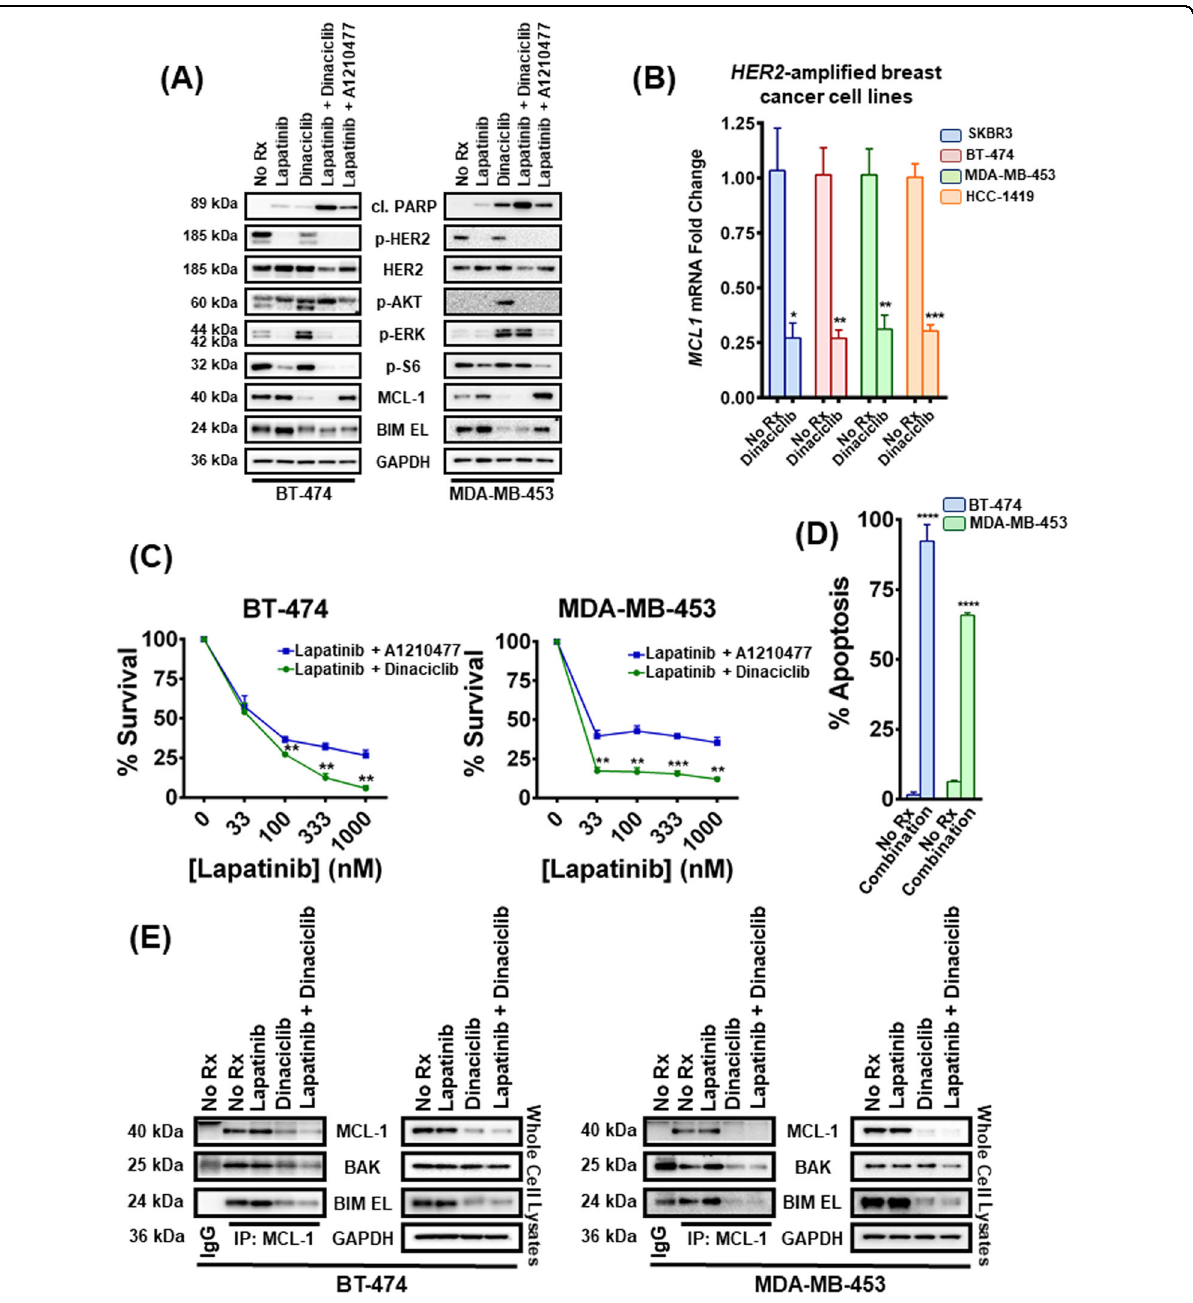
Fig. 1 Dinaciclib sensitizes HER2- ampli fi ed breast cancer cells to lapatinib and liberates BAK from MCL-1. A BT-474 and MDA-MB-453 cells were treated with no drug, 1 μ M lapatinib, 100nM dinaciclib, their combination and the combination of 1 μ M lapatinib with 10 μ M A1210477 for 6 and 12h, respectively. Whole-cell lysates were prepared, subjected to western blotting and probed for the indicated proteins. B Cells from SKBR3, BT-474, MDA-MB- 453, and HCC-1419 HER2 -ampli fi ed breast cancer cell lines were treated with no drug or 100nM dinaciclib for 2h, and levels of the abundance of MCL-1 mRNA were analyzed by qPCR. Data are normalized to ACTB ; n = 3; error bars indicate ±SEM. C BT-474 and MDA-MB-453 cells were treated with increasing concentrations of lapatinib and 10 μ M A1210477 or with increasing concentrations of lapatinib and 100nM dinaciclib for 24 and 72h respectively, and the percentage of viable cells was determined. n = 3; error bars indicate ±SD. D BT-474 and MDA-MB-453 cells were treated with no drug or the combination of 1 μ M lapatinib and 100nM dinaciclib for 24 and 72h, respectively and the percentage of annexin V/PI-positive cells was determined by FACS. n = 3, error bars indicate ±SD ( “ No Rx ” : No drug). E MCL-1 complexes were immunoprecipitated from the indicated HER2 -ampli fi ed breast cancer cell lines following 6h (BT-474) and 12h treatment (MDA-MB-453) with no drug, 1 μ M lapatinib, 100nM dinaciclib, and their combination. An IgG-matched isotype antibody was served as an immunoprecipitation control. The interaction between MCL-1 and BIM EL/BAK proteins was investigated ( “ No Rx ” : No drug). For Fig. 1B – D two-tailed Student ’ s t test was performed. p values were corrected for multiple testing using the Bonferroni method. Differences were considered statistically different if p <0.05. A p value<0.05 is indicated by *, p <0.01 by **, p <0.001 by ***, p <0.0001 by ****. Of fi cial journal of the Cell Death Differentiation